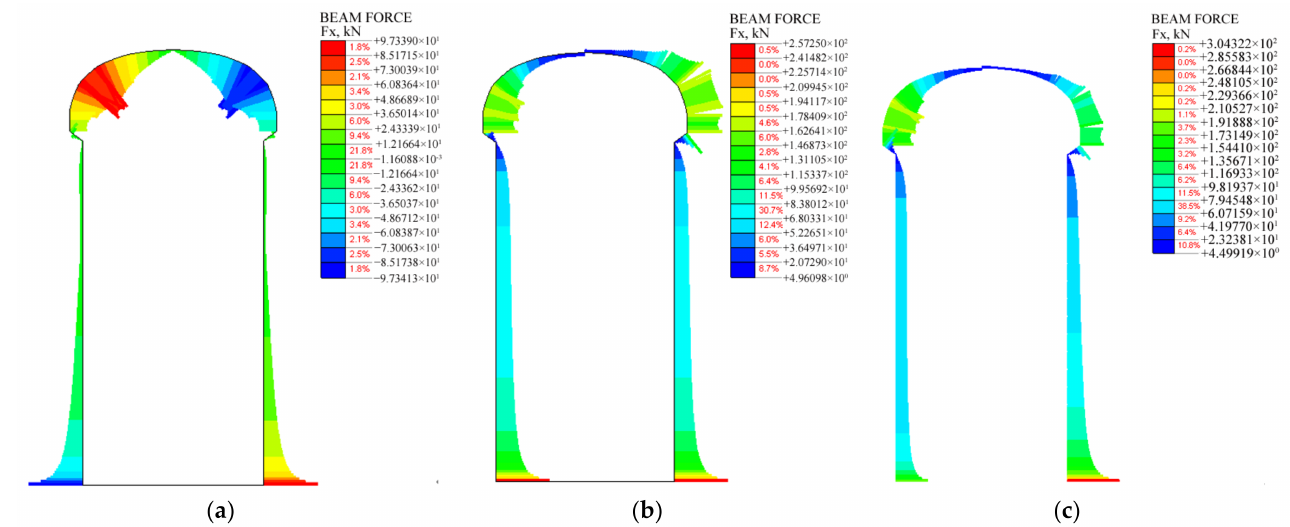
Figure 7. Thrust force along the shotcrete subjected to horizontal ( a ), vertical ( b ), and both ( c ) compo- nents of ground motion.